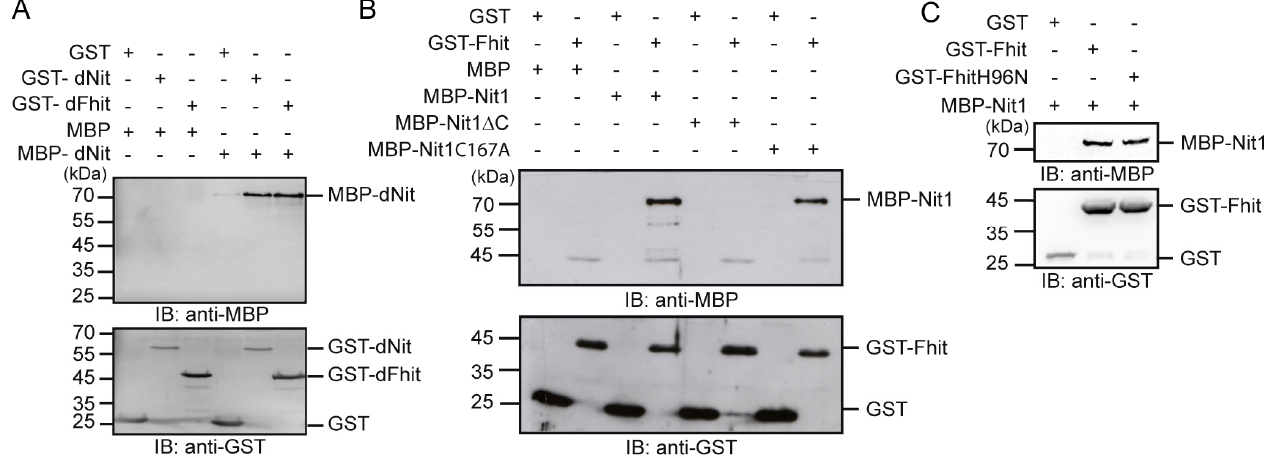
Figure 5. Direct interaction of recombinant Nit1 and Fhit fusion proteins. GST pull-down assays of recombinant dNit and dFhit domains of the D. melanogaster NitFhit fusion protein ( A ) or human Nit1 and Fhit fusion proteins as indicated ( B ). GST and MBP were used as controls. ( C ) Binding of enzymatic-dead GST-FhitH96N to wildtype MBP-Nit1. The presented blots are representatives of